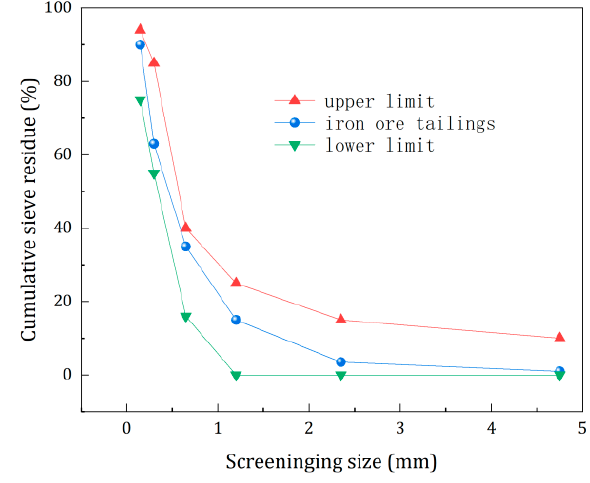
Figure 1. The grain gradation curve of iron ore tailings.